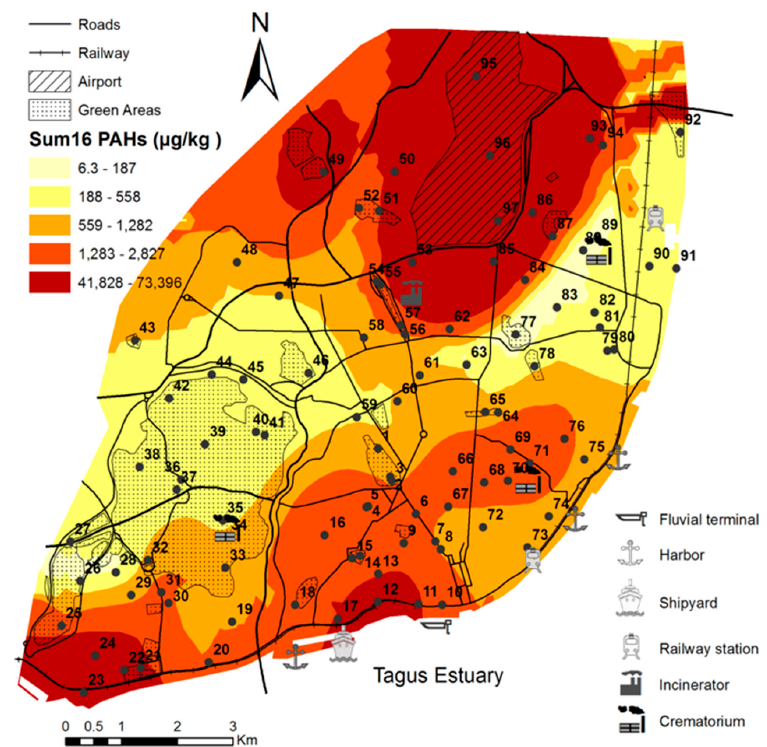
Figure 1. Locations of sampling sites and contour map interpolated by ordinary kriging of the distribution of the Sum16PAHs. The class limits correspond to the minimum, the quartiles (25, 50, and 75), the upper outlier limit, and the maximum value. Some of the most important sources are identified. Concentrations of the Sum16PAHs obtained in surface soils ranged between 6.3 and 73,395 µg kg − 1 , with a mean value of 2645 µg kg − 1 and a median of 559 µg kg − 1 (Figure 1 and Table 1). Compared to